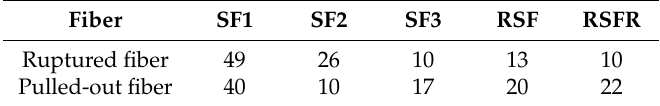
Figure 6. Ruptured and pulled-out steel fibers on a fracture surface observed by an optical microscope after fracture energy testing. Table 3. Number of ruptured or pulled-out steel fibers on a surface of beam specimen during fracture energy testing.